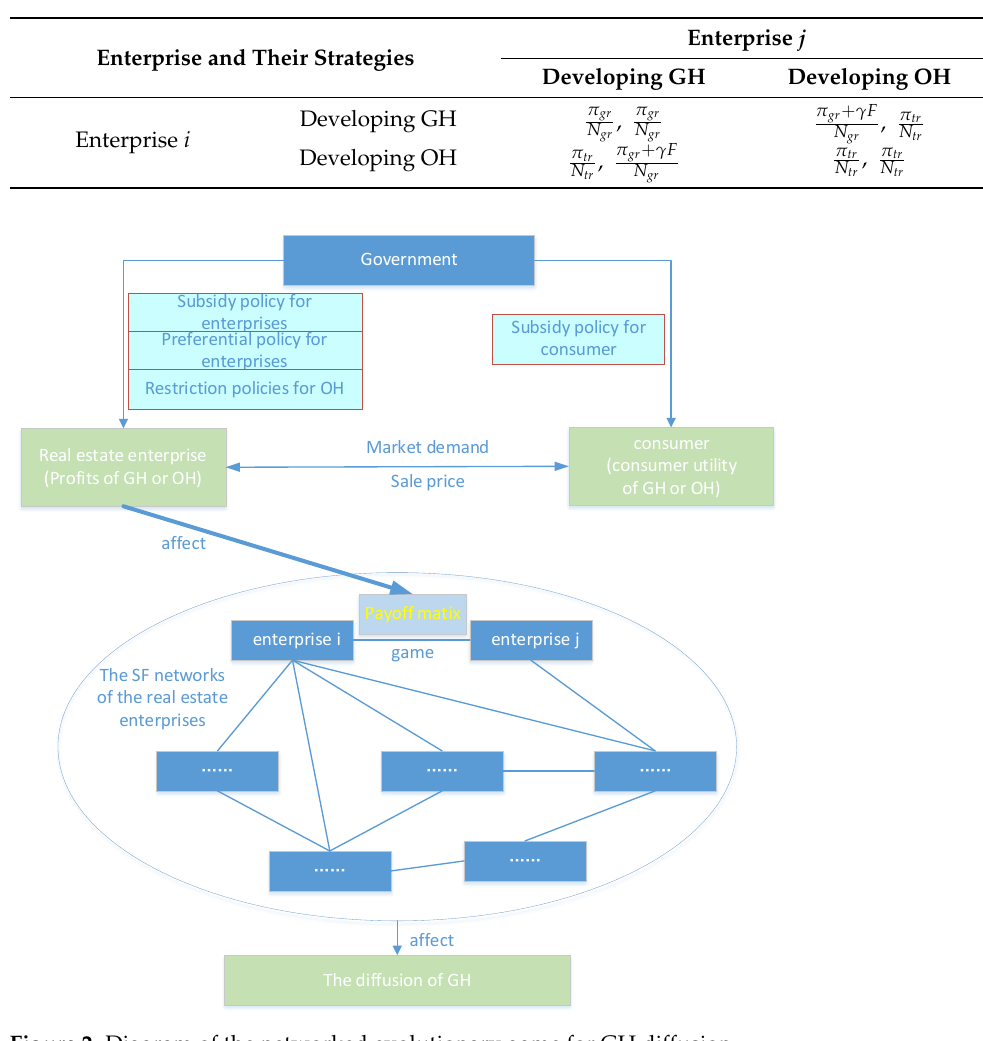
Table 2. The payoff matrix for both enterprises.